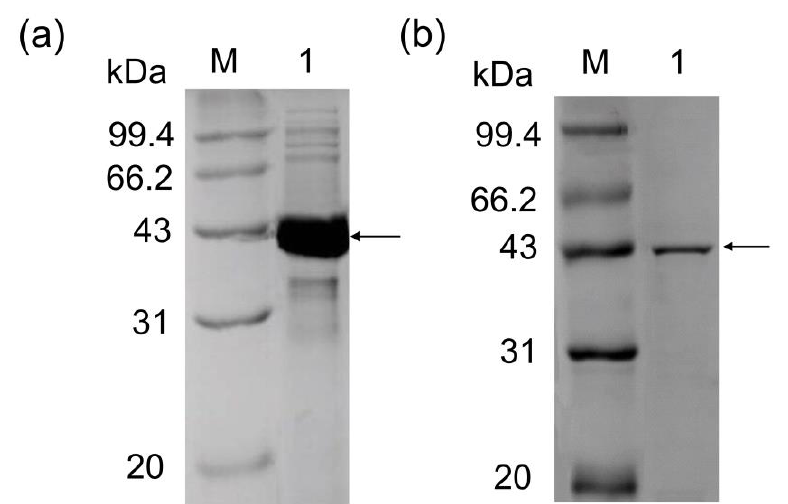
Figure 1. SDS-PAGE analysis of recombinant P. geniculata AGEase. ( a ) Lanes: M, molecular mass markers (97.4, 66.2, 43, 31, and 20 kDa). 1, lysates of whole-cell expressing recombinant P. geniculata AGEase after IPTG induction for 24 h. ( b ) Lanes: M, molecular mass markers (97.4, 66.2, 43, 31, and 20 kDa). 1, P. geniculata AGEase purified by gel column Superdex 200.